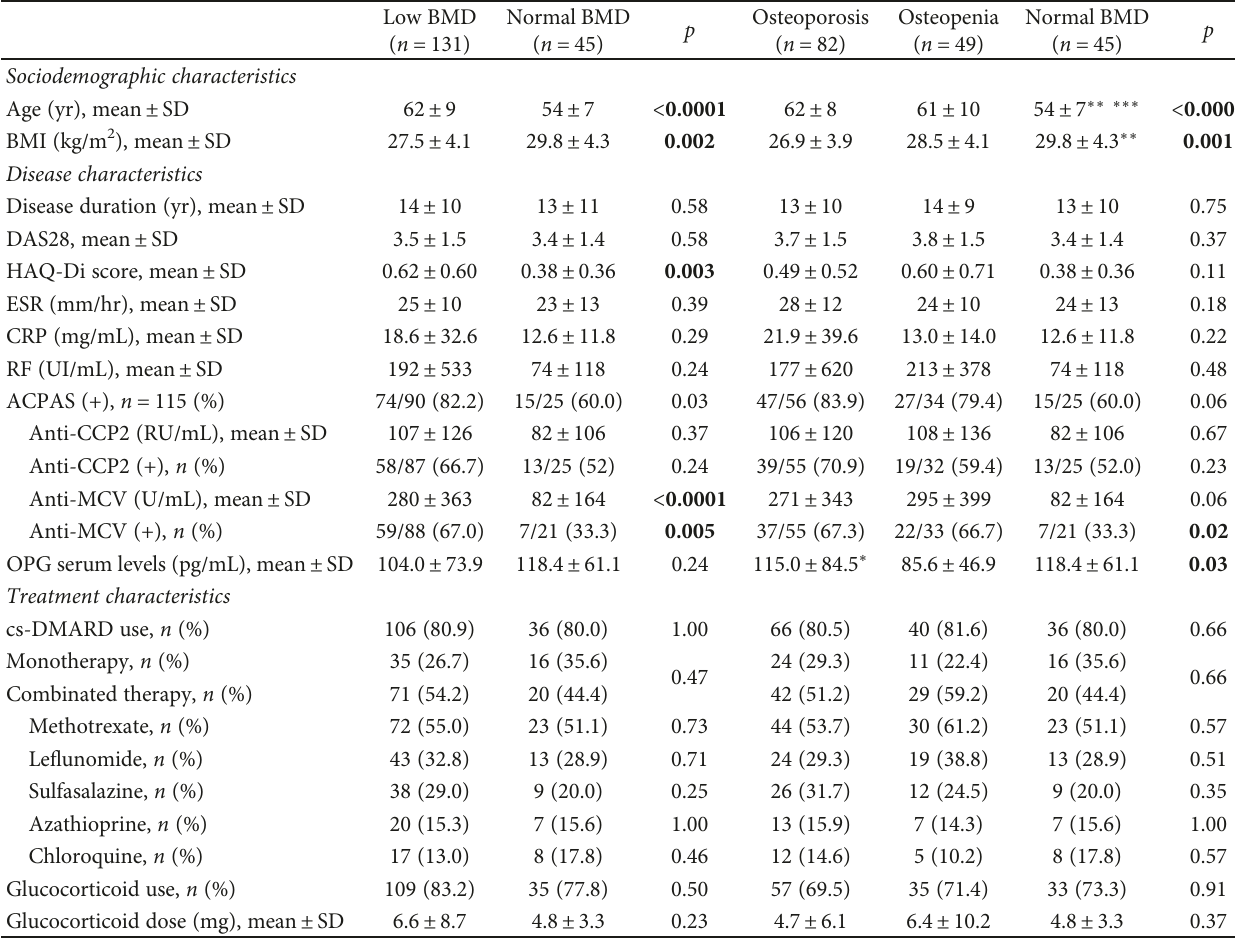
Table 1: Comparison of selected patient characteristics between rheumatoid arthritis (RA) with low bone mineral density (BMD) versus RA with normal BMD and among subgroups of patients with RA with osteoporosis (OP), osteopenia, and normal